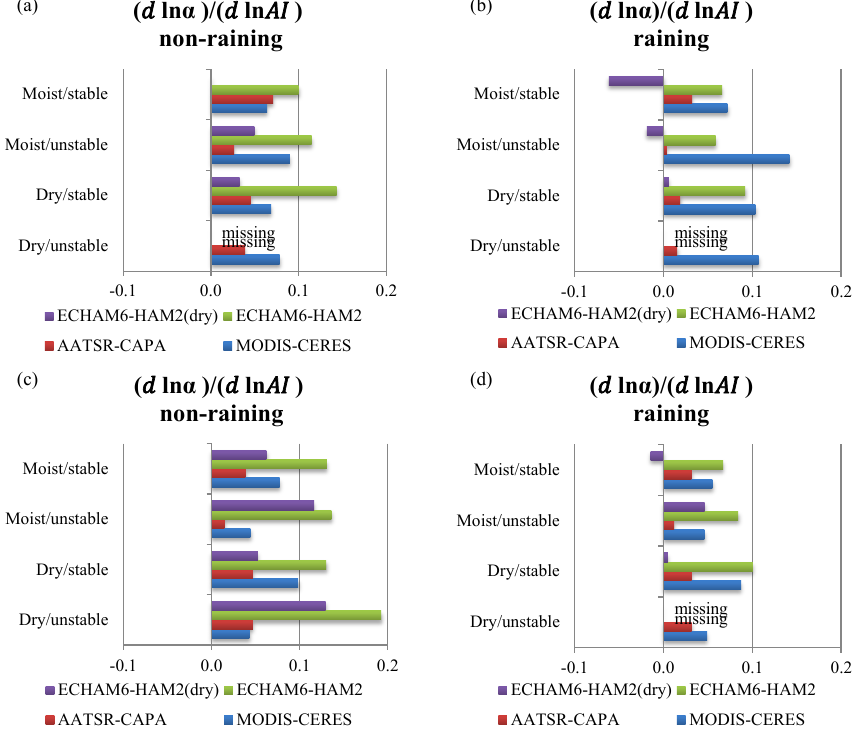
Figure 8. Same as Fig. 5 but for the shortwave cloud albedo susceptibility to changes in AI for ECHAM6-HAM2 (E6_Ref), E6_Ref without aerosol water uptake (dry), AATSR–CAPA and MODIS–CERES in the (a, b) Californian and (c, d) Peruvian stratocumulus regions. Not enough aerosol–cloud data pairs are available in the stratocumulus regions to make the linear regression significant for the dry/unstable regimes in ECHAM6-HAM2, except for the non-raining scenes in the Peruvian region. The MODIS–CERES data are from Christensen et al.